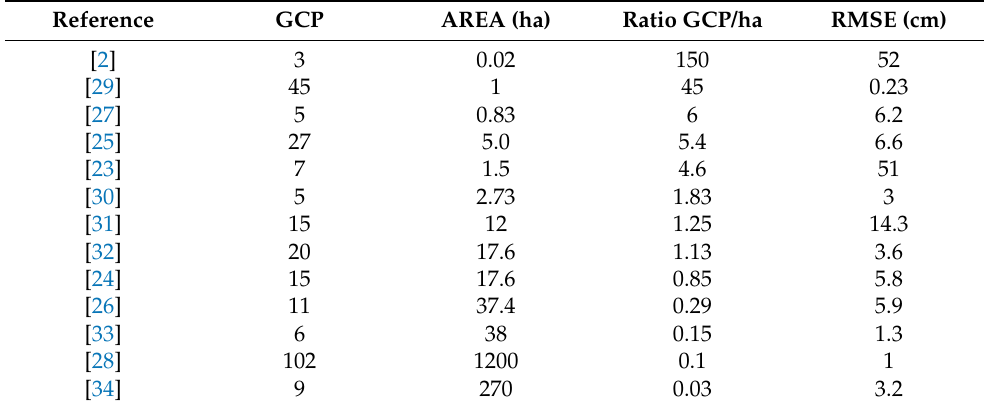
Table 1. Studies on the number of GCP and their relation with the study area.